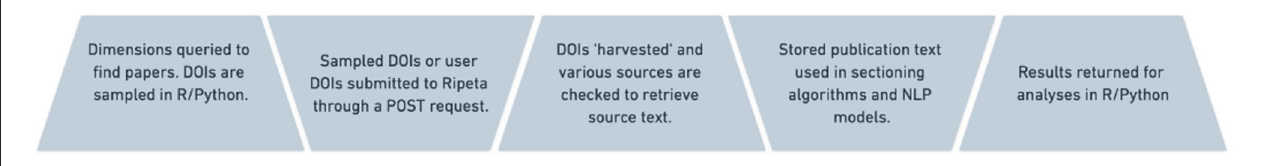
FIGURE 1 | Manuscript collection